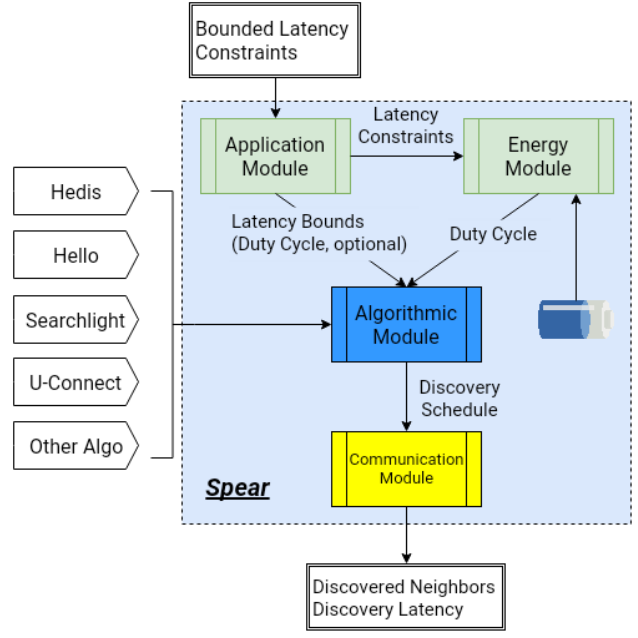
Figure 3. Overview of